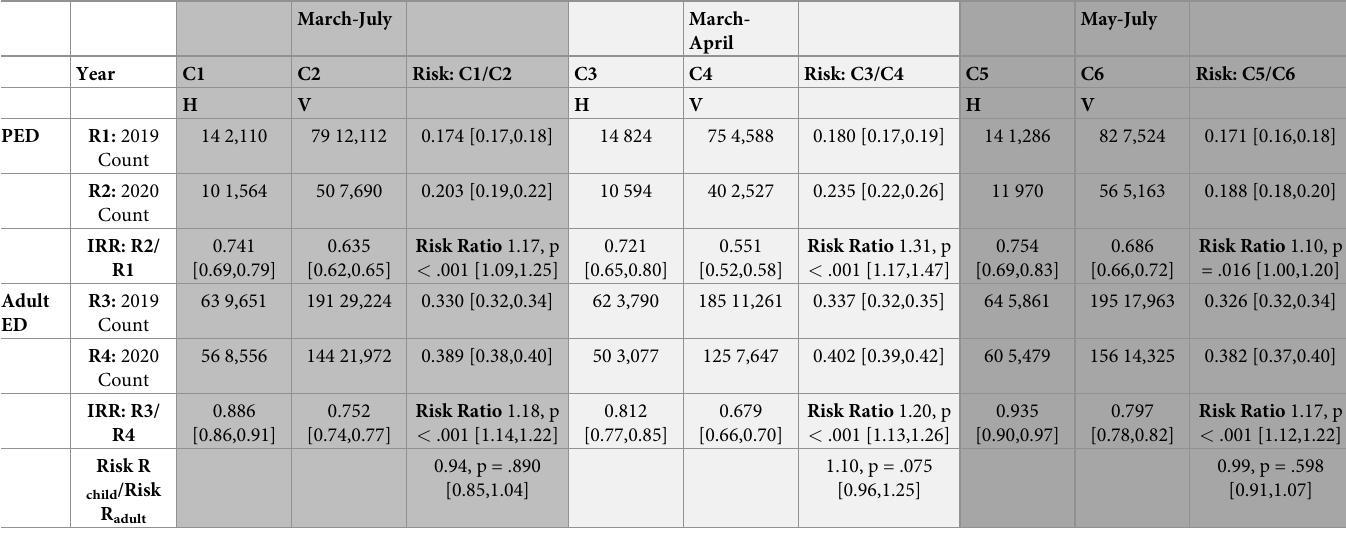
Table 1. Incidence rate ratio and risk ratio between 2019 and 2020; PED and adult ED.